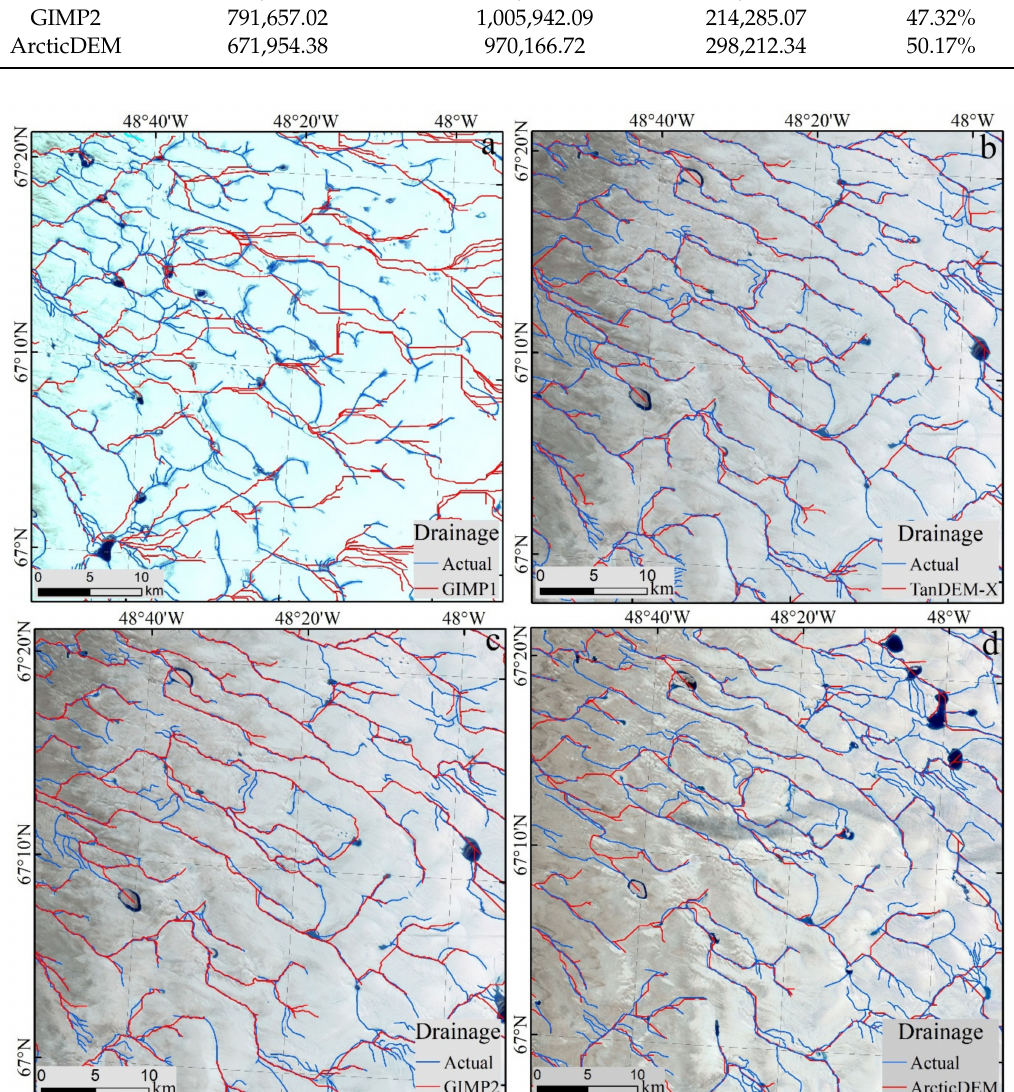
Figure 12. ( a ) The river network extraction results for GIMP1 are compared with the actual digitized river network. The background image is from Landsat-7 and was acquired on July 20, 2005. ( b ) The river network extraction results for TanDEM-X compared with the actual digitized river network. ( c ) The river network extraction results for GIMP2 compared with the actual digitized river network. The background image for ( b , c ) are from Landsat-8 and was acquired on August 06, 2014. ( d ) The river network extraction results of ArcticDEM are compared with the actual river network digitized. The background image is from Landsat-8, and acquired on July 10,